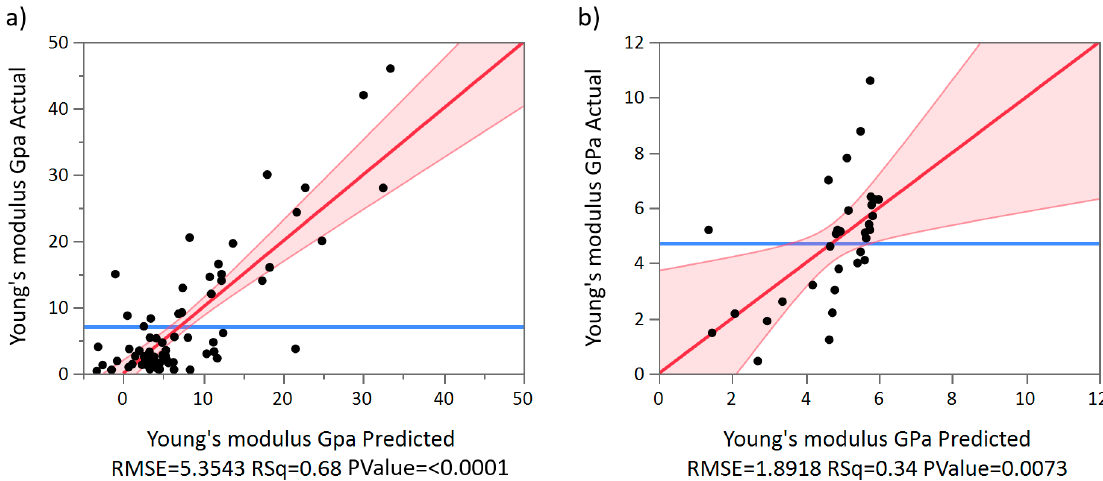
Figure 13. Overall predicted model of elastic modulus actual versus an elastic modulus predicted ( a ) beam-based scaffolds, and ( b ) TPMS-based scaffolds.